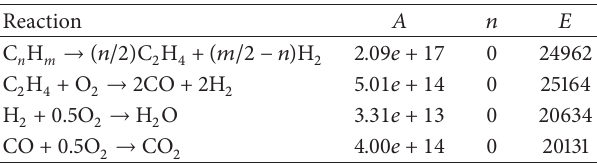
Table 1: Chemical kinetic mechanism for kerosene combustion